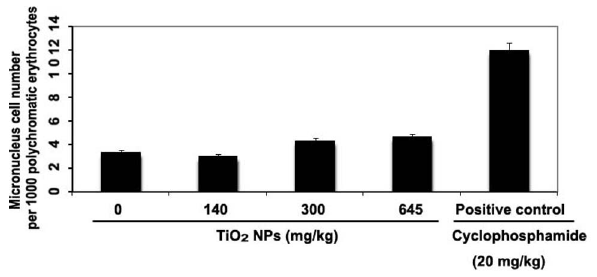
Figure 4. Micronucleus test result. Average of micronucleus cell number per thousand polychromatic erythrocytes in animals was analyzed. No significant difference was observed among the micronu- cleus cell number between TiO 2 NPs treated mice and the control.